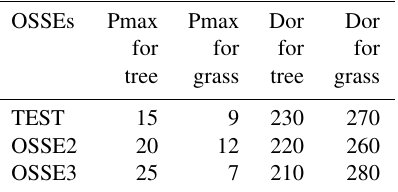
Table 1. Parameter settings for TEST, OSSE2 and